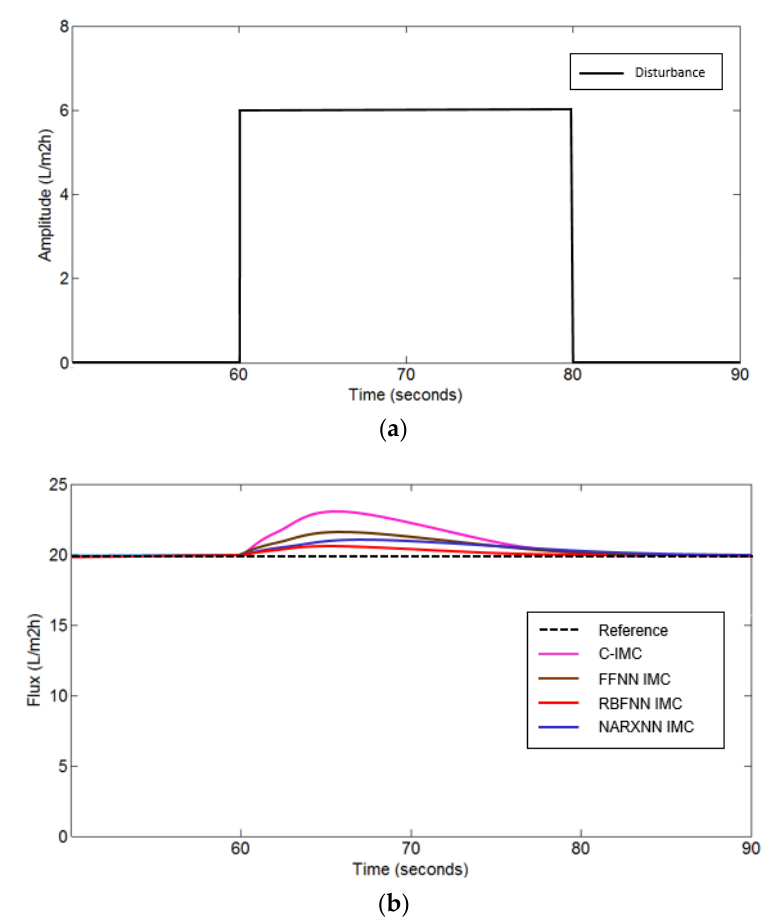
Figure 16. 30% step disturbance; ( a ) amplitude of 6 L/m 2 h, ( b ) flux performance.